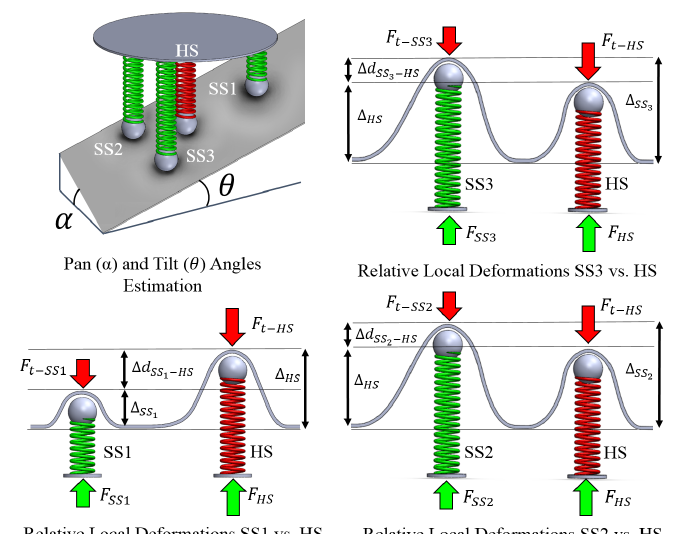
Figure 2. Operating mechanical principle. Contact between the soft surface and the sensor showing the interacting forces and the differential force between the linear model with an embedded hard spring (HS) and the three modules with embedded softer springs (SS1, SS2,